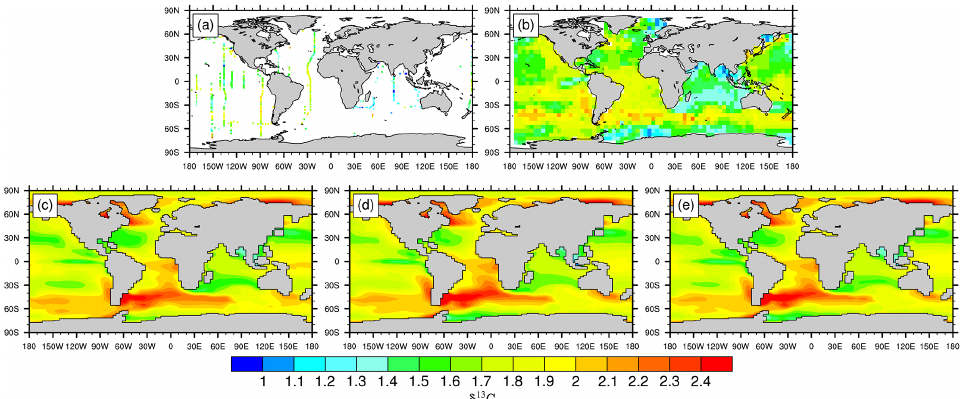
Figure 6. Surface values of δ 13 C for the 1990s from (a) cruise data compiled by Schmittner et al. (2013), (b) 5 ◦ extrapolated gridded data from Gruber and Keeling (1999) and Gruber and Keeling (2001), and (c–e) the biotic model, using the biological fractionation from (c) Rau et al. (1989), (d) Laws et al. (1995), and (e) Keller and Morel